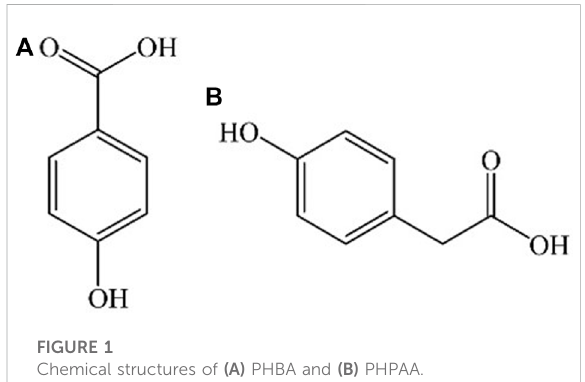
Chemical structures of (A) PHBA and (B) PHPAA.